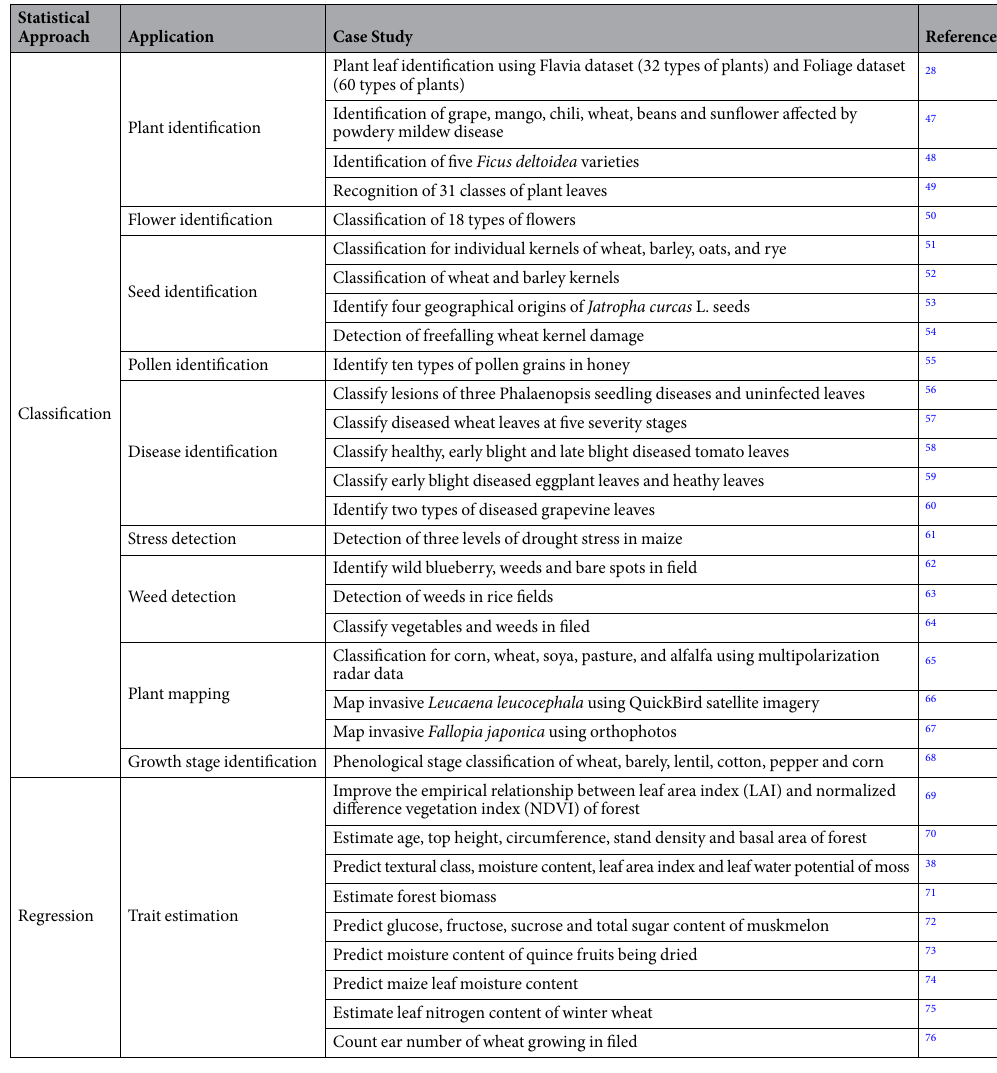
Table 1. Examples of agriculture-related research utilizing GLCM-based texture